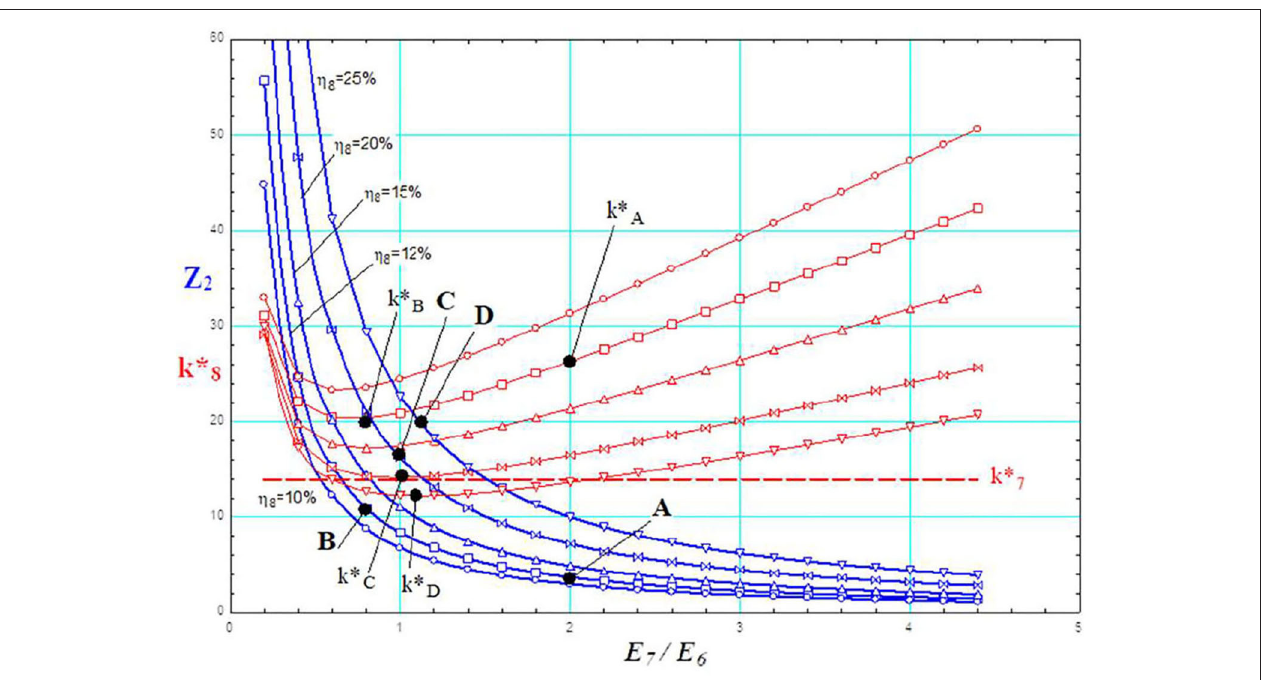
FIGURE 4 | Parametric plot of the relation Z2 = f (E7/E6, E8/E1) evaluating the fixed capital cost for the manufacturing phase and the corresponding unit exergy cost k*8 for the solar system in Figure 2